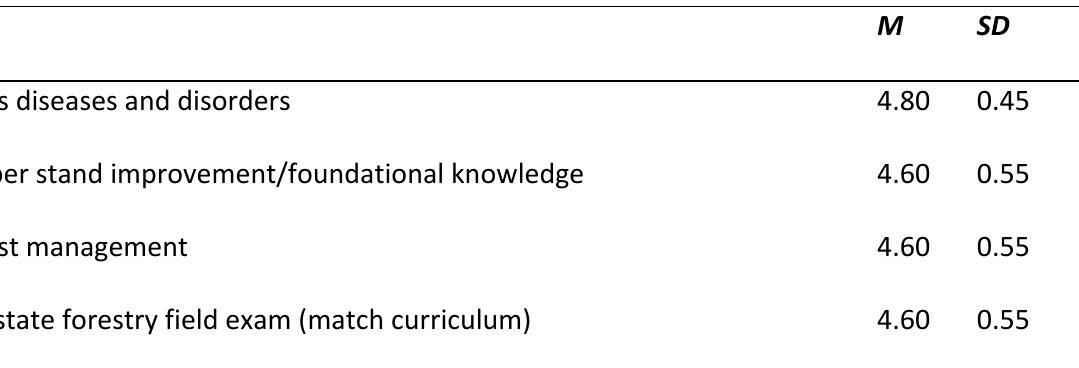
Round Two – Levels of Agreement: Professional Development Needs in Forestry and Forest Ecosystems (Session